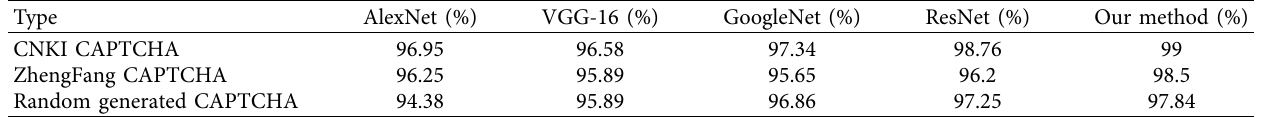
Table 2: Comparison of recognition accuracy of different